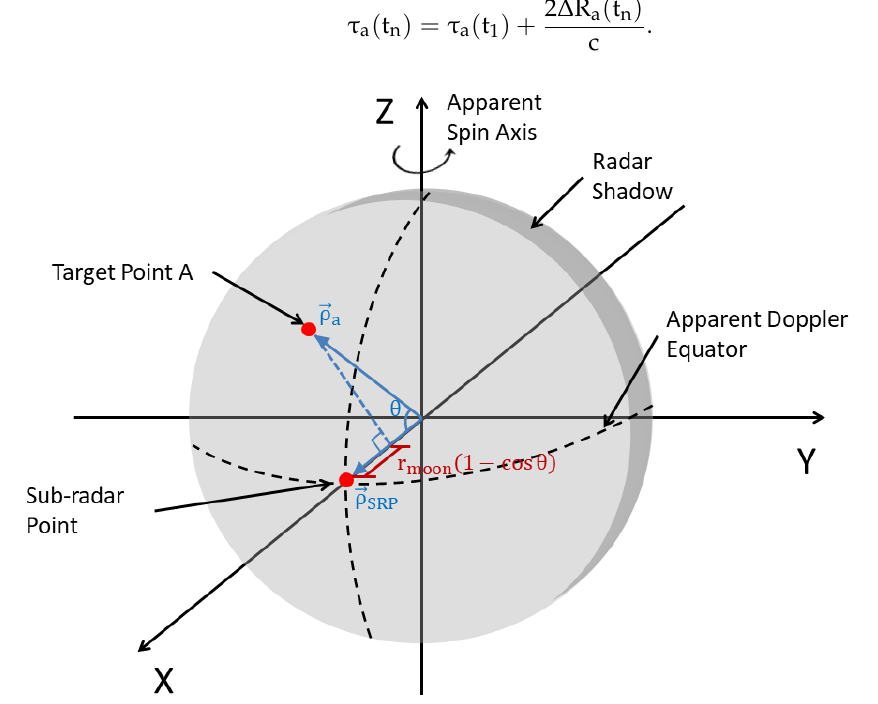
Figure 2. The back projection processing. ( a ) Data matrix after pulse compression. The red line rep- resents the migration track of target imaging point A. The yellow dots represent the signal samples on the migration track of point A, which are obtained by interpolation. ( b ) Image obtained by back projection. The red dot denotes target imaging point A.